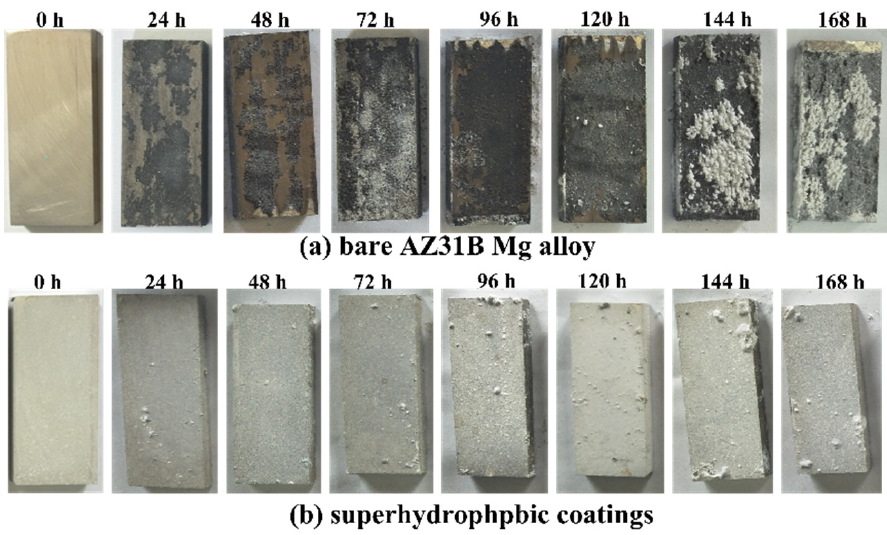
Figure 11. The optical surface photo after salt spray experiment: ( a ) bare AZ31B Mg alloy, ( b ) superhydrophobic coatings. The dimensions for all samples were 70 × 50 × 5 mm).